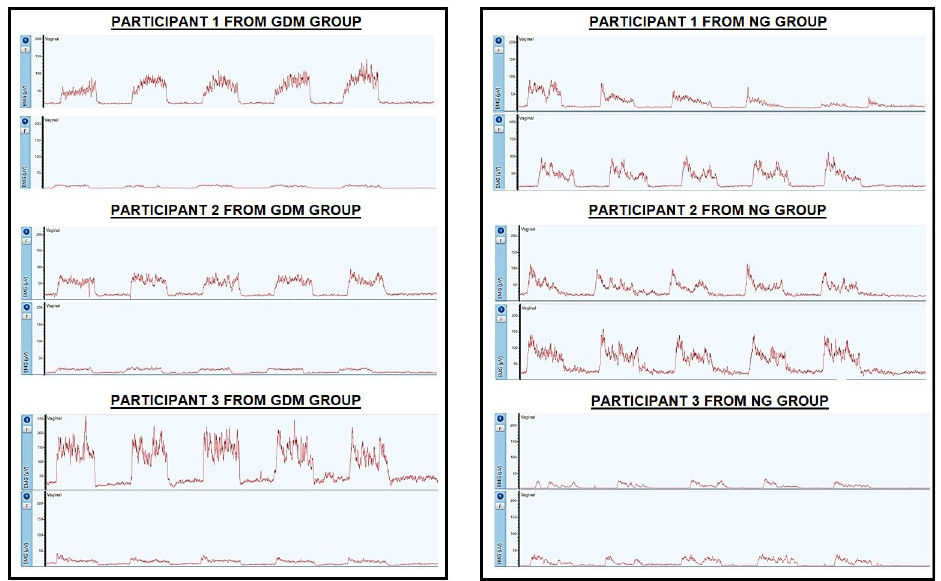
Fig 4. EMG RMS characteristics from 24–28 to 36–38 weeks of gestation of different 3 participants from DMG and NG group.